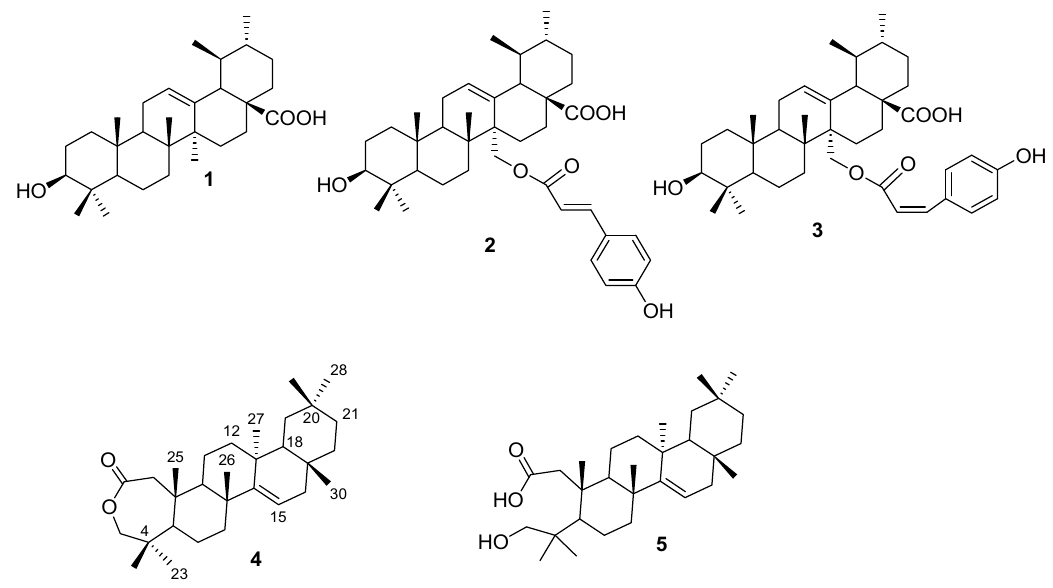
Figure 1. Chemical structures of isolated compounds from P. pycnantha